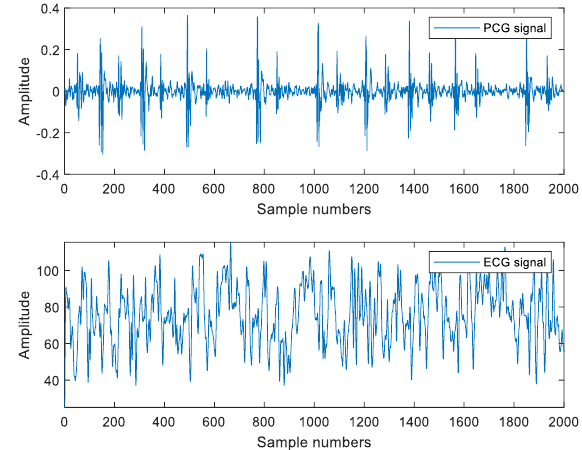
Figure 7. PCG and ECG